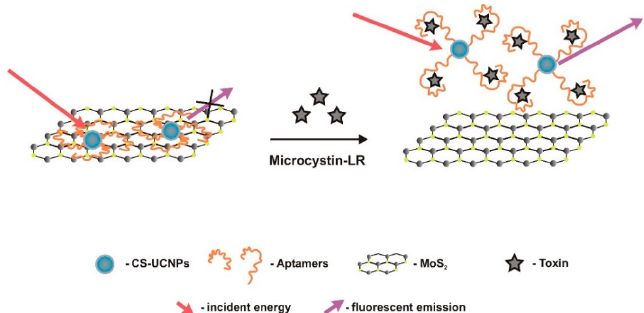
Figure 9. Optical aptasensor that uses the higher fluorescence of lanthanide ions doped core/shell upconversion nanoparticles (CS-UCNPs) and MoS 2 nanosheets [53]. In the presence of microcystin-LR, aptamers combined preferentially with MC-LR, changing conformation, detaching from MoS 2 and recovering fluorescence.